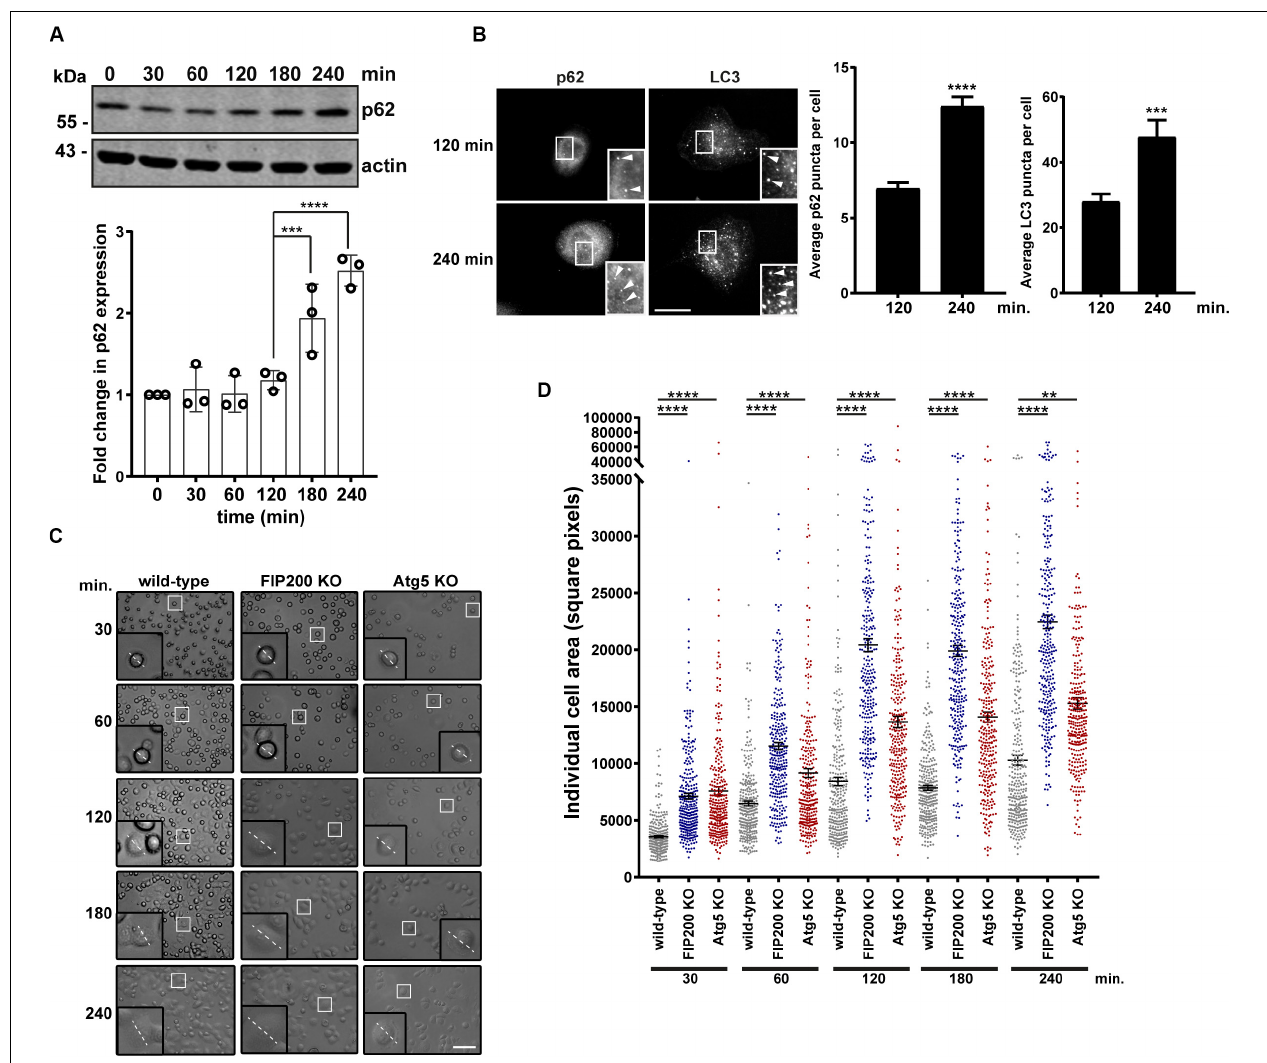
FIGURE 2 | FIP200 or Atg5 depletion increases fibronectin-induced cell adhesion and spreading. (A) Western blot analysis of cell lysates harvested along the time course of fibronectin-induced MCF10A wild-type cell spreading. Immunoblotting was performed against the indicated proteins. Quantitation of p62 expression was normalized to actin and represented as the fold change from the zero time point (cells in suspension). Results represent at least 3 independent experiments. (B) Immunofluorescence microscopy of MCF10A cells following attachment and spreading on fibronectin for indicated time points. Cells were immunostained for p62 and LC3. Scale bar = 10 µ m. Quantitation was performed on multiple images from random fields of view. The number of p62 or LC3 puncta (indicated with arrowheads) were quantified from 100 cells for p62 and 13–15 cells for LC3 across 3 independent experiments. Results represent the average number of p62 or LC3 puncta per cell. Error bars represent SEM. (C) Brightfield images across the time course of adhesion to fibronectin of MCF10A wild-type, FIP200 KO, and Atg5 KO cells. Higher magnification regions illustrate phenotypic differences and dotted line represents representative cell diameter. Scale bar = 100 µ m. (D) Quantitation of individual cell area represented as square pixels were plotted across the time course of fibronectin adhesion. Results represent 50–100 cells per experiment, repeated at least 3 independent times. Black bar represents the mean and error bars are the SEM. ** p < 0.01, *** p < 0.001, **** p <